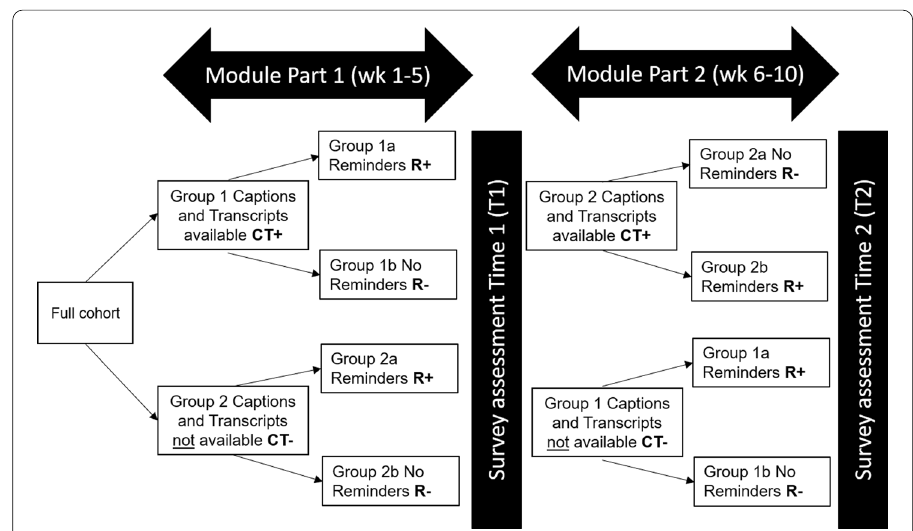
Fig. 1 An overview of the quantitative phase of data collection indicating alignment to the module teaching and the two survey